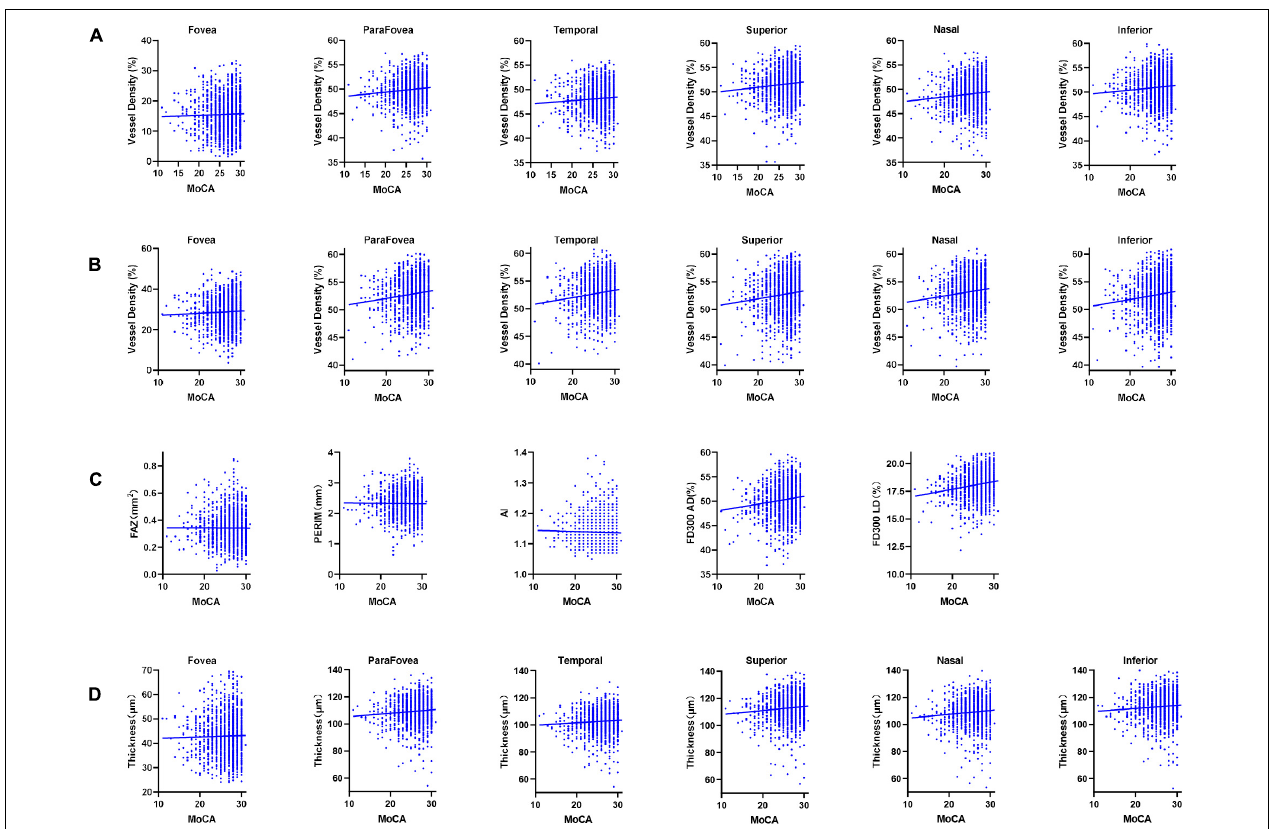
FIGURE 3 | Scatter diagrams of the retinal measurements and cognitive function. (A) Superficial RCP vessel density. (B) Deep RCP vessel density. (C) FAZ, PERIM, AI, FD300 AD, and FD300 LD. (D) GCC thickness. RCP, retinal capillary plexus; FAZ, foveal avascular zone area; PERIM, foveal avascular zone perimeter; AI, acircularity index; FD300 AD, vessel area density within a 300 µ m width ring surrounding the FAZ; FD300 LD, vessel length density within a 300 µ m width ring surrounding the FAZ; GCC, ganglion cell complex; MoCA, Montreal Cognitive